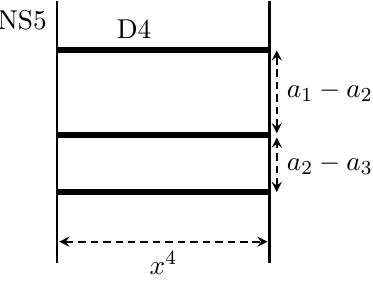
between NS5 branes in the 4- 4d